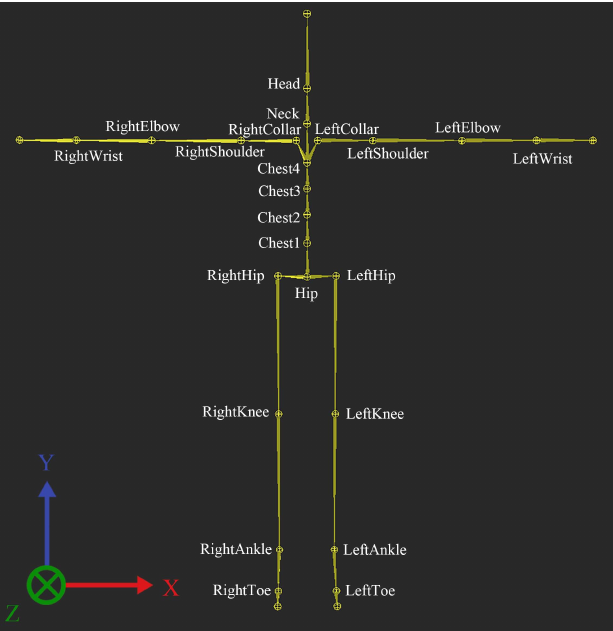
Figure 3. The Joint Structure of the Mowing Motion